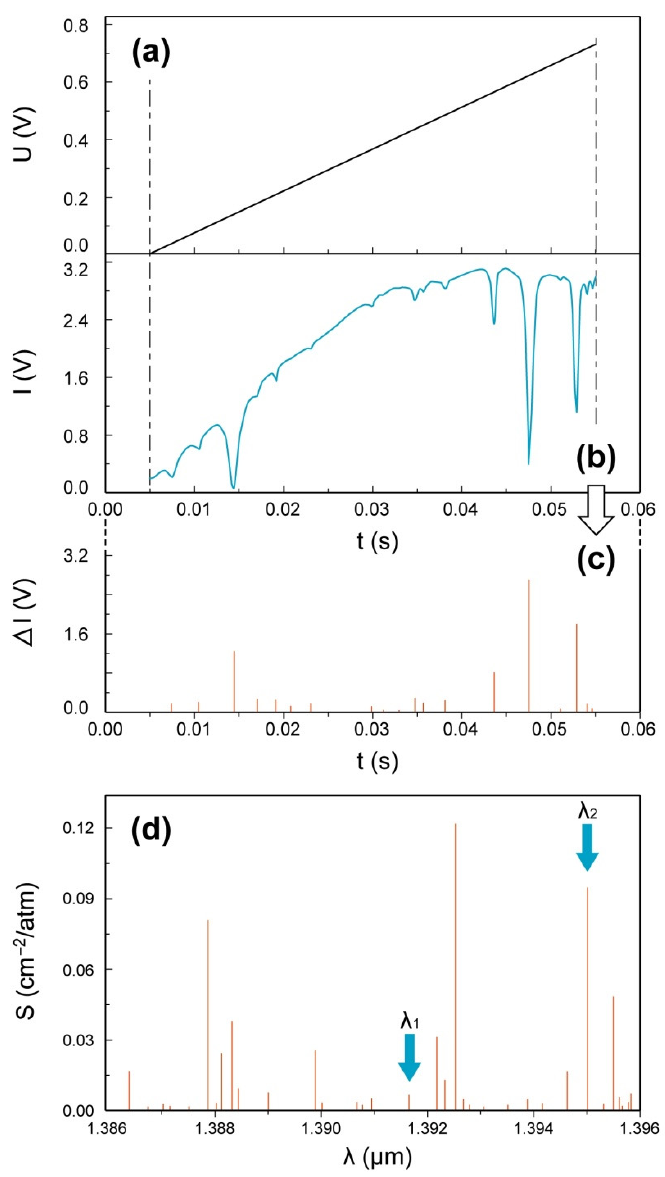
Figure 4. Variation in ( a ) laser driving voltage and ( b ) transmitted light intensity in a half circle with ( c ) peak positions and strengths, and ( d ) the line strength distribution calculated from the HITRAN [17] database.